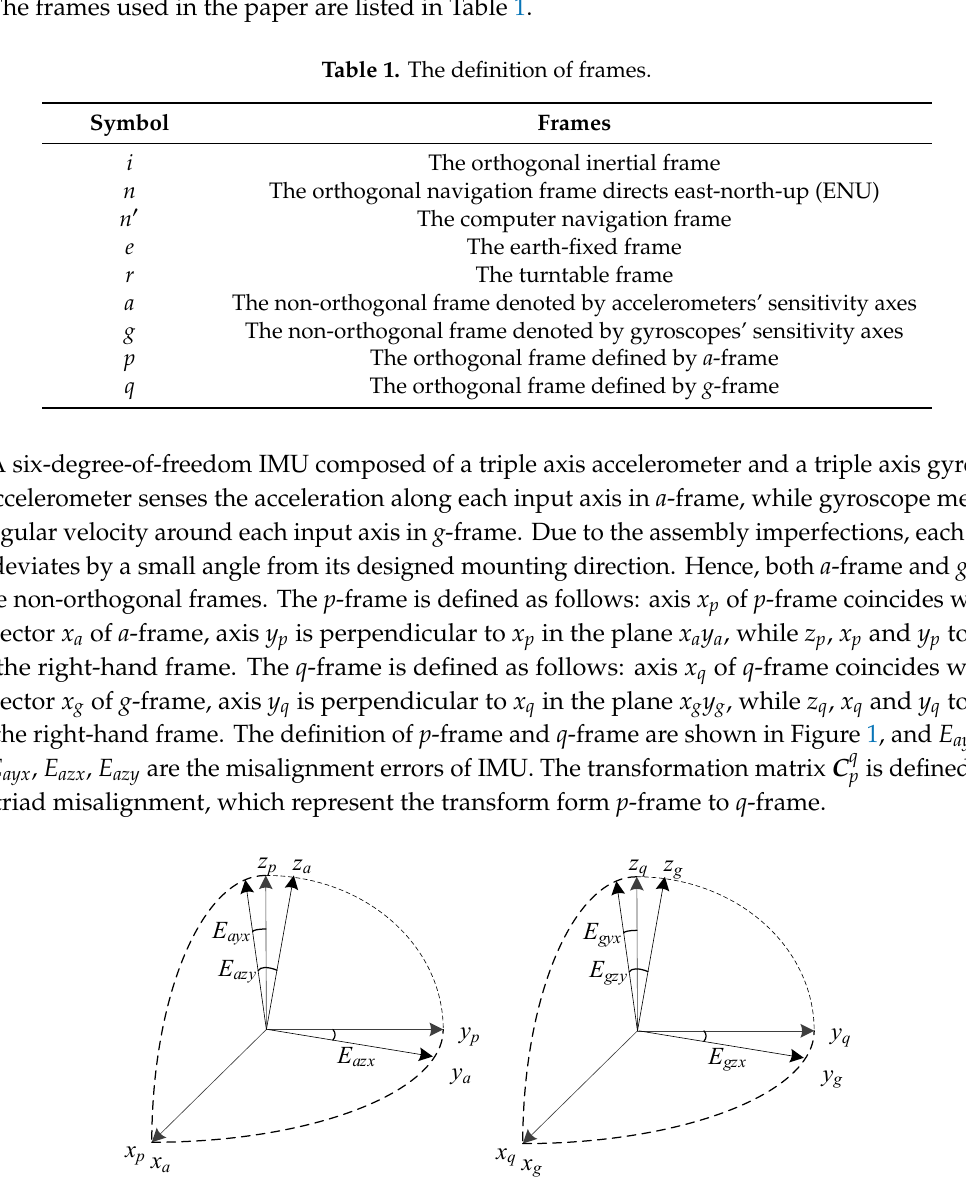
Figure 1. Definition of the p -frame and q -frame.